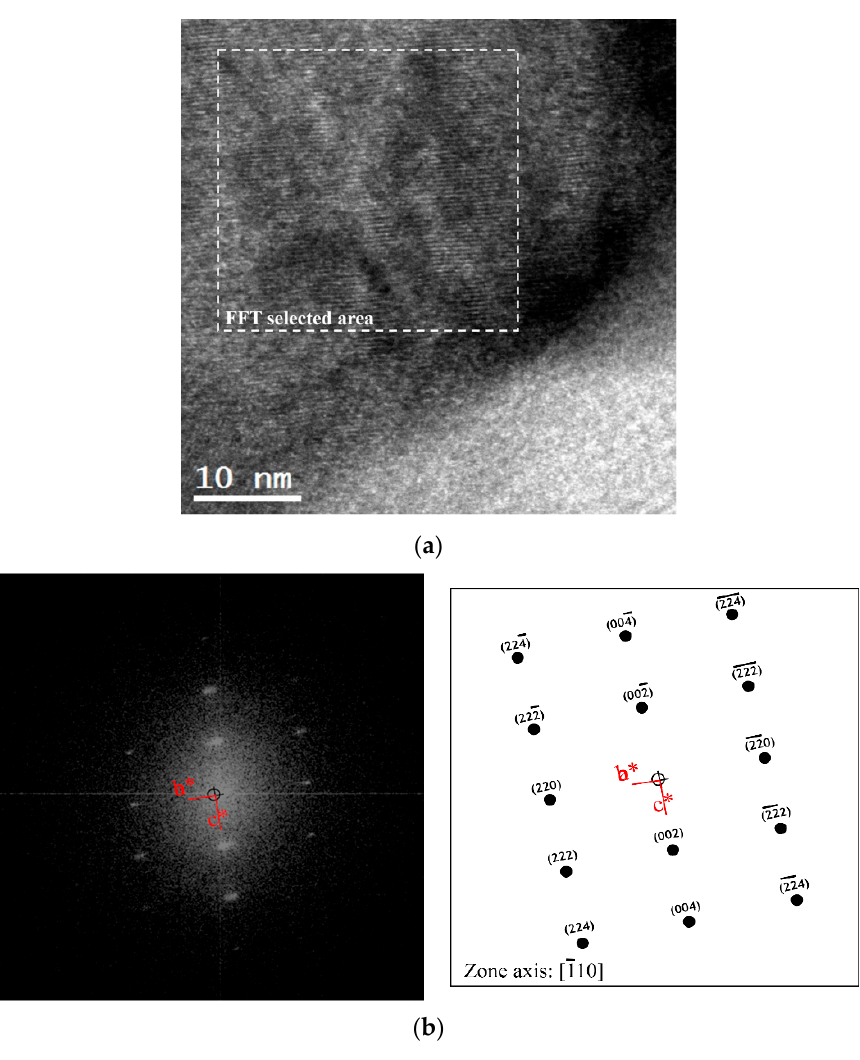
Figure 10. ( a ) High resolution TEM (HRTEM) image of the reaction layer close to the TiNi of the TiNi/Ti6Al4V joint and ( b ) Fast Fourier transform (FFT) of the selected area indicated in ( a ) and the indexing scheme of the AlNi 2 Ti phase.